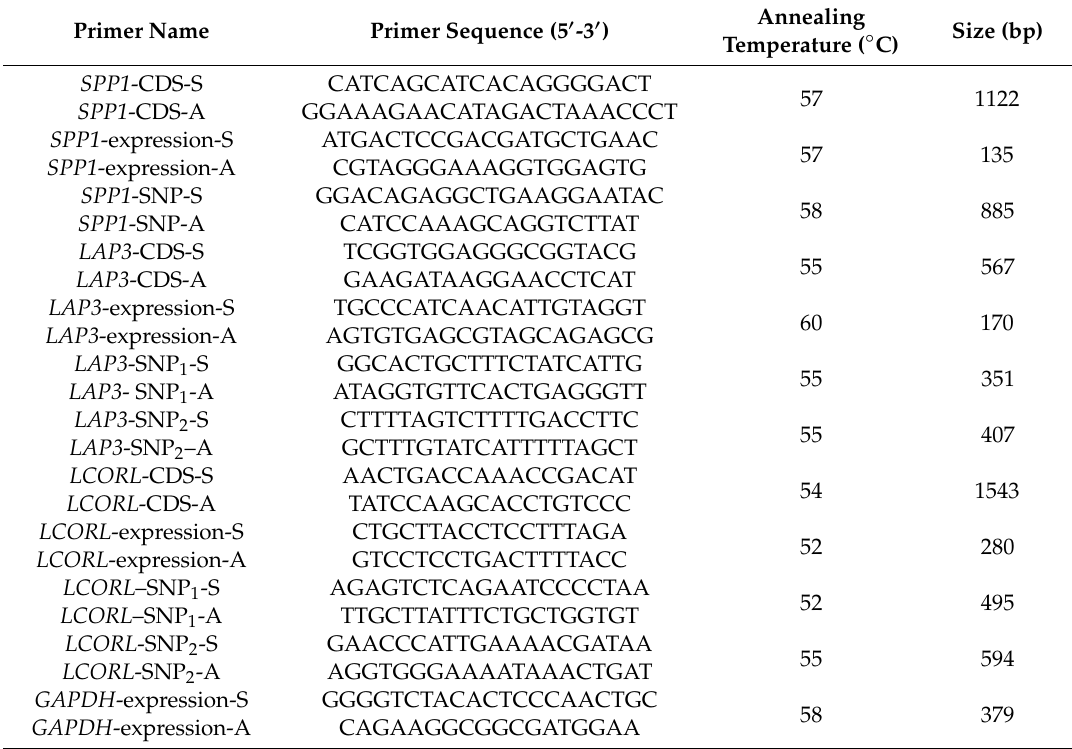
Primer pairs designed for sheep genes secreted phosphoprotein 1 ( SPP1 ), leucine aminopeptidase 3 ( LAP3 ), and ligand dependent nuclear receptor corepressor like ( LCORL